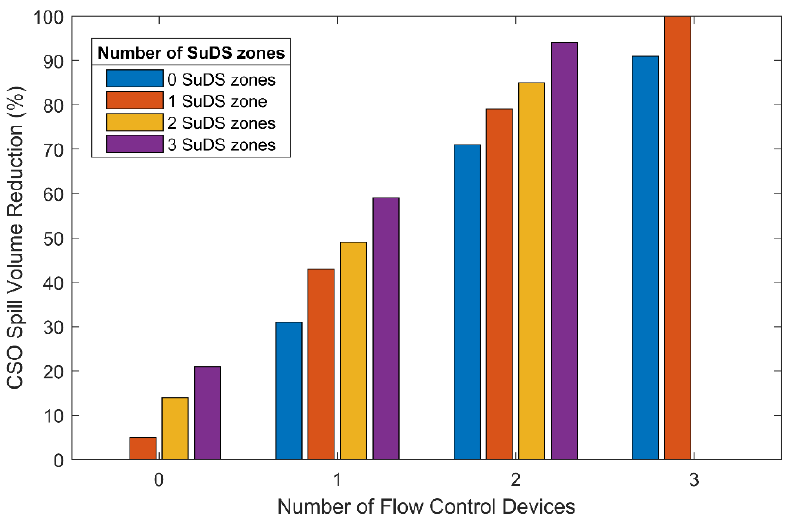
Figure 5. CSO spill volume reduction obtained in the Arendonk catchment for different combinations of intervention measures (the CSO spill volume in the baseline network was equal to 731 m 3 ).